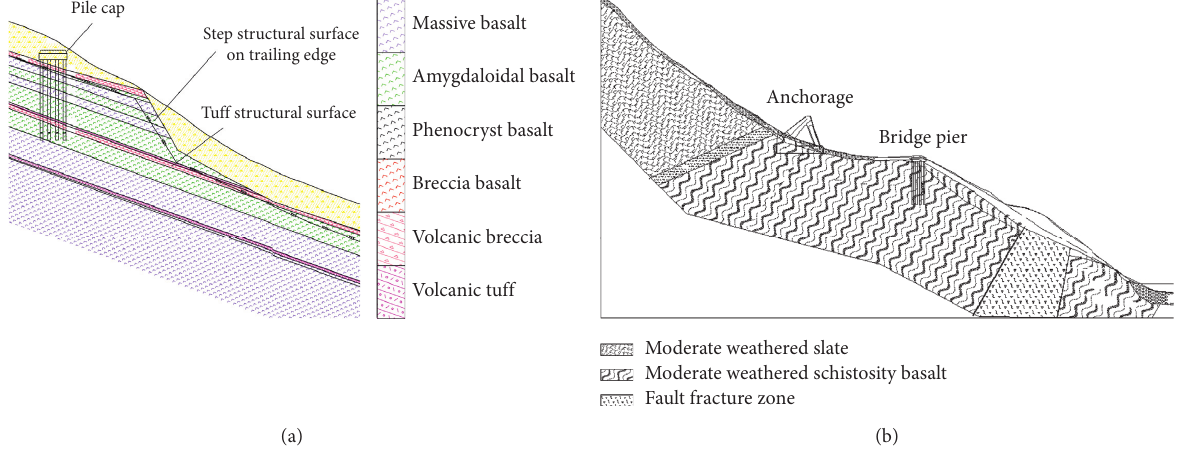
Figure 3: Drawing of the slope: (a) Huaping slope; (b) Lijiang